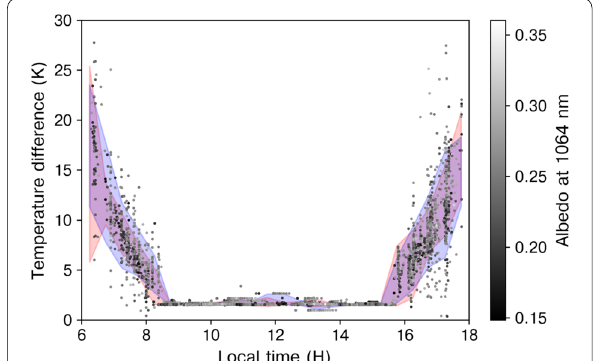
Fig. 6 Brightness temperatures at Tycho crater in the nightside. The red points are the brightness temperatures at the latitude of 43.0°– 43.5°S and longitude of 11.0°–11.5°E in Diviner GCP at channel 5. The blue and green points are the brightness temperatures at the center of Tycho crater in HSD at bands 11 and 14, respectively. The error bars are estimated from the background noise level in each image. The black dashed and dotted lines show surface temperature models of lunar rock and regolith at the latitude of 43°S, respectively. The yellow points are the best-fit regolith temperatures in our analysis